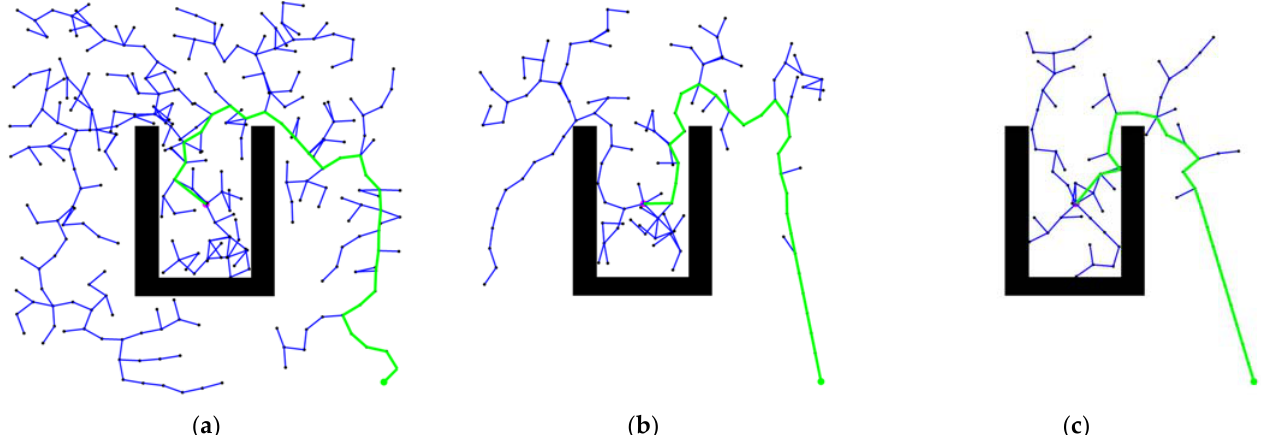
Figure 7. The obstacle avoidance path planning result of scenario B: ( a ) RRT; ( b ) G_RRT; ( c ) GA_RRT. The average experimental data for Scenario B is shown in Table